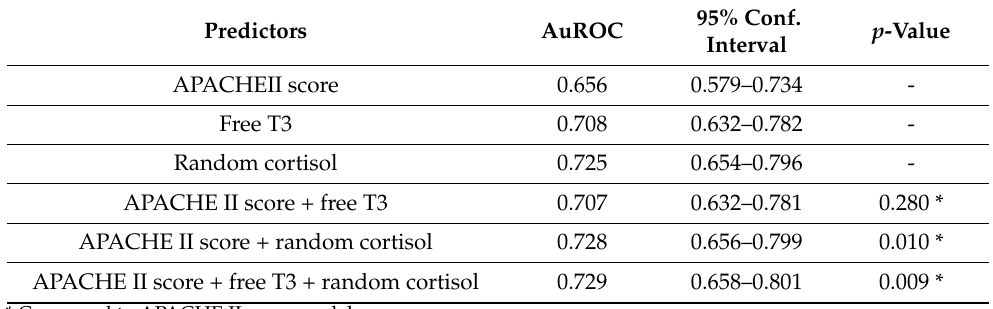
Table 4. Performance of predictors presented as area under ROC curve.